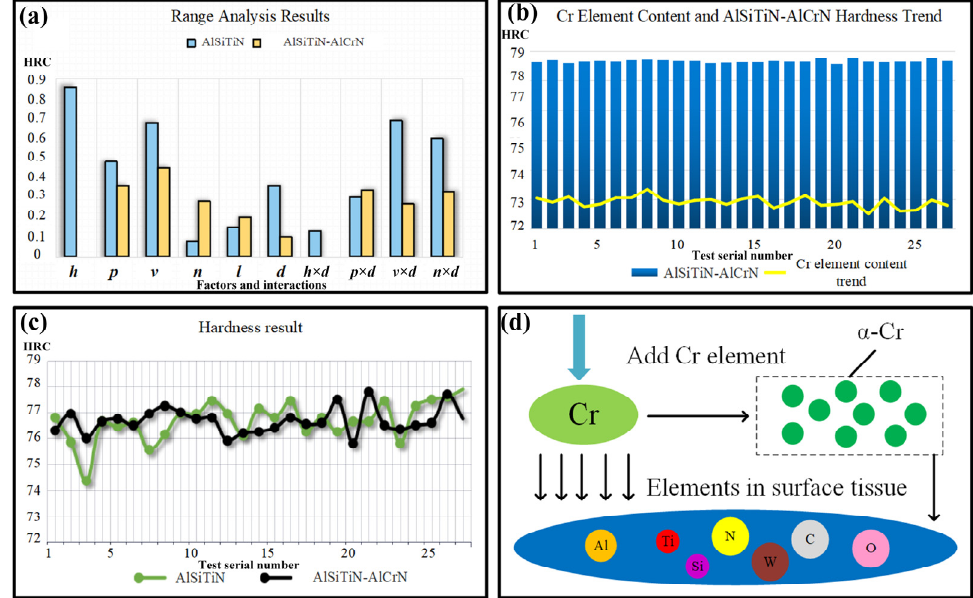
Figure 2. Hardness test results and the action mechanism. ( a ) hardness test range analysis results, ( b ) Cr element content and AlSiTiN–AlCrN hardness trend, ( c ) hardness test results, ( d ) the schematic diagram of Cr element addition.